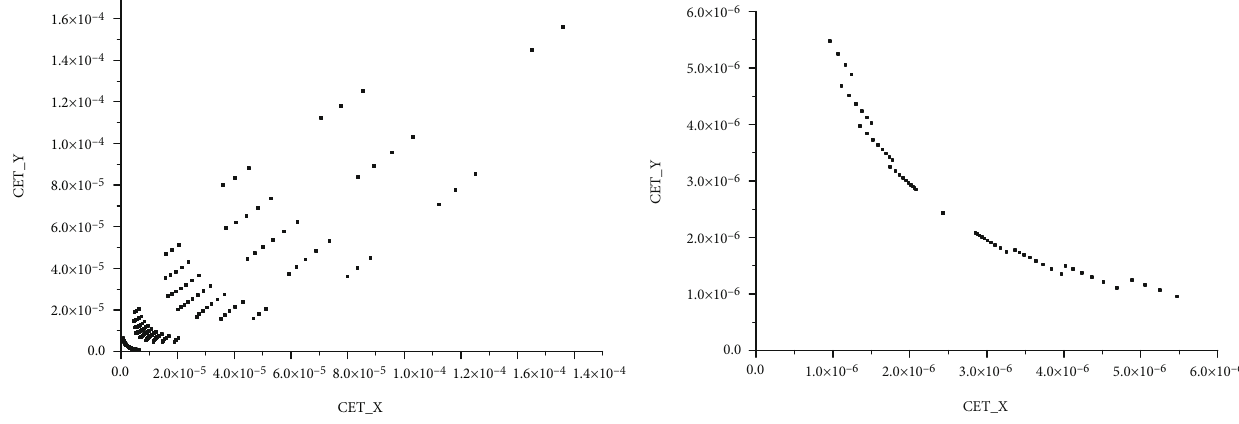
variation of points A and B. 3